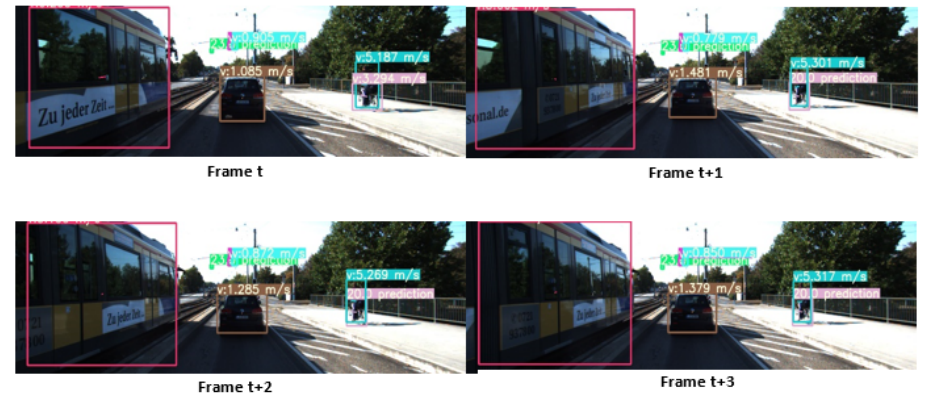
Figure 11. Tracking results in the road environment.